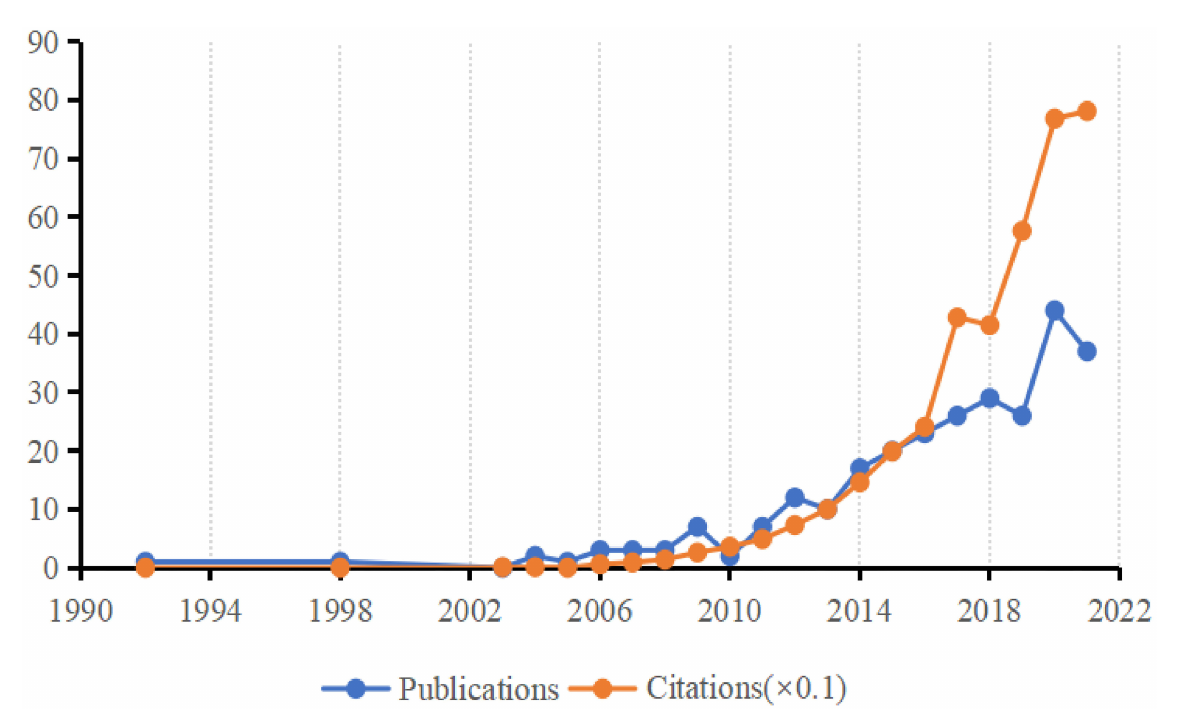
FIGURE2 Sum of publications and citations. The number of publications and citations from 1992 to 2021 is described by a line chart, where blue represent the number of publications and yellow represent the number of citations (